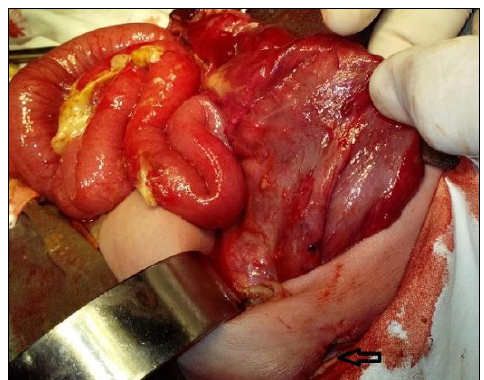
Figure 3: Complete congenital pouch colon a wall of which was exteriorized as window colostomy